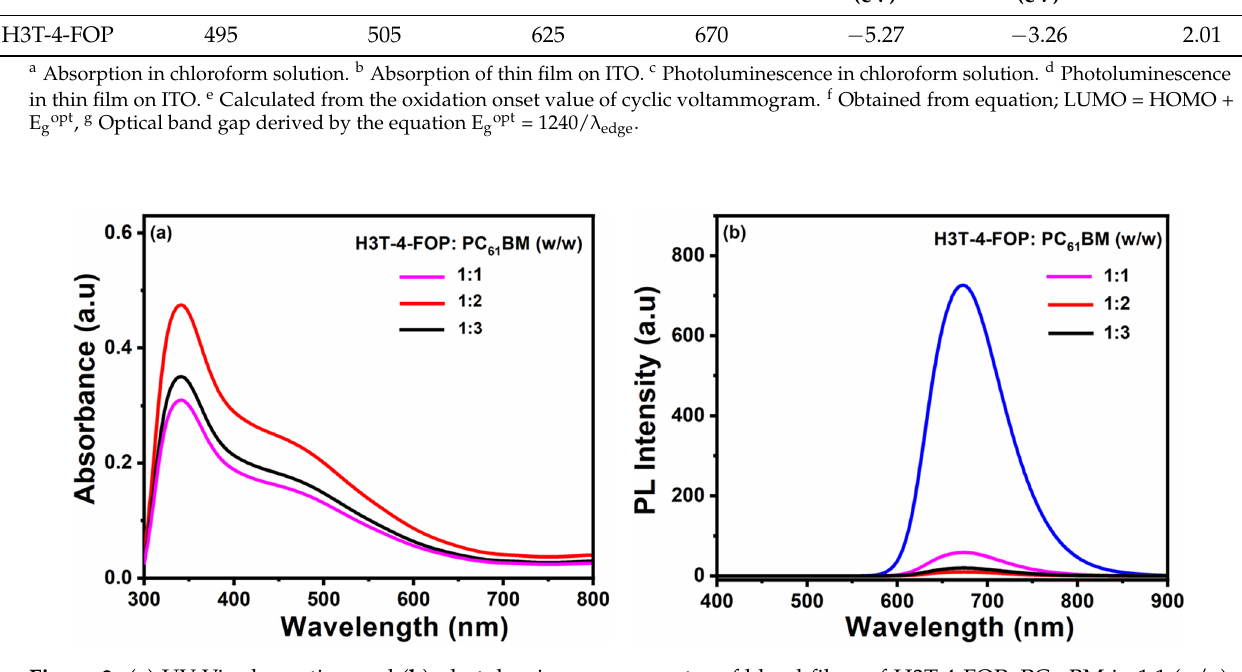
Figure 3. ( a ) UV-Vis absorption and ( b ) photoluminescence spectra of blend films of H3T-4-FOP: PC 61 BM in 1:1 (w/w), 1:2 (w/w), and 1:3 (w/w) ratios.